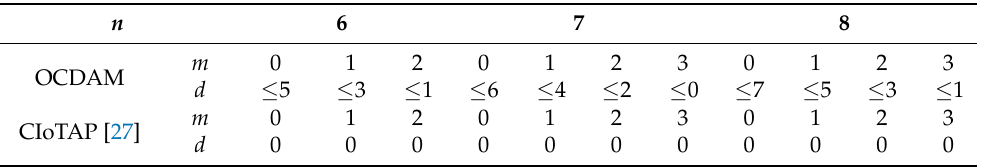
Table 2. The comparison of the proposed protocol Optimal Consensus with Dual Abnormality